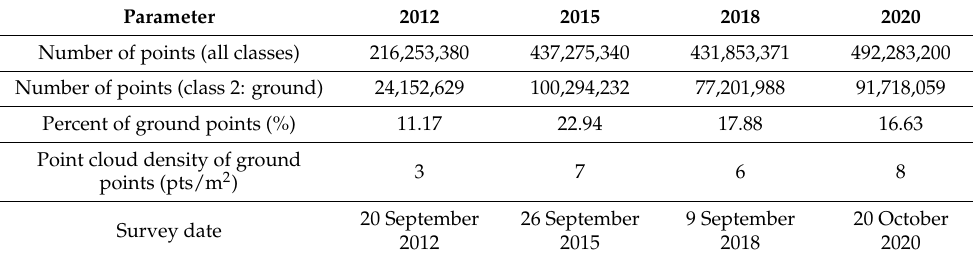
Figure 2. Morphological and lithological variability of western and eastern section of Wolin Island cliff coast. The upper image presents active high cliffs made of clay and sandy clay sediments with well-developed landslides. The bottom image presents active sandy cliffs moderately covered with grass. Oblique image taken by a drone (DJI Mavic 2 Pro) at an altitude of 100 m (Source: this study). Table 1. Survey dates and basic parameters of analyzed point clouds (Source: this